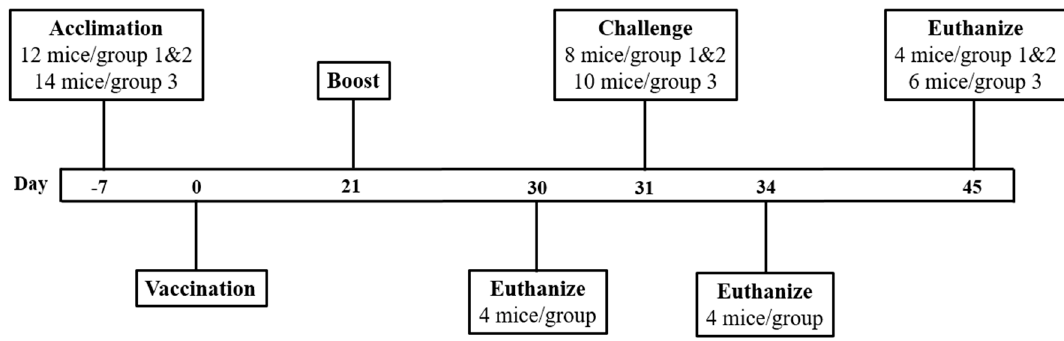
Figure 4. The outline of mice vaccinated with the reassortant mutant QTV virus and challenged with the homologous BC15 (H7N9) virus. BALB / c mice ( n = 12 or 14, equal males and females) were intranasally vaccinated on days 0 and 21 with 50 µ L of MEM (control) or the QTV virus (1 × 10 3 PFU). On day 30, four mice per group (two males and two females) were euthanized for splenocyte isolation. On day 31, the remaining mice were intranasally challenged with MEM (control) or a lethal dose of BC15 (H7N9) (WT) (1 × 10 3 PFU). On day 34 (three days post-challenge), four mice per group (two males and two females) were euthanized for sampling. The trial concluded on day 45 (14 days post-challenge), where the remaining mice were euthanized and sampled. Sampling included serum and lung tissue.